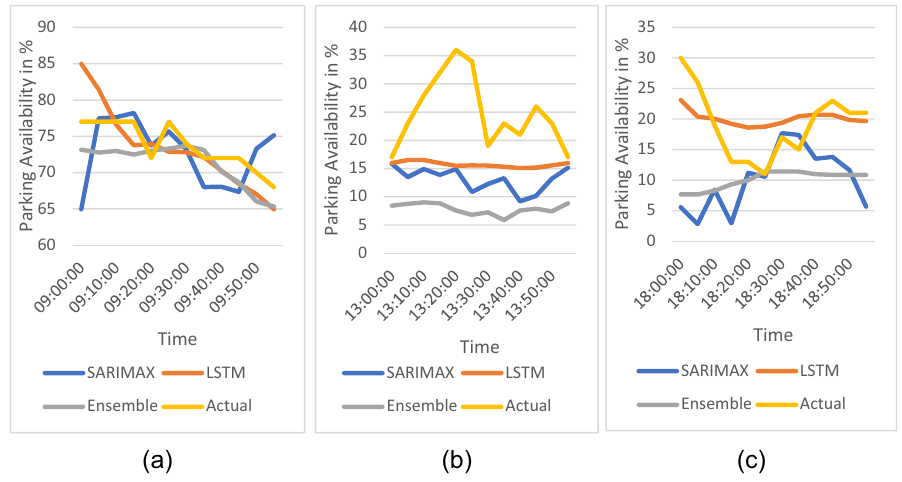
Figure 7: Prediction plot of methods without visitor trend data for weekday. ( a ) Predictions without visitor trend data at 9 AM on a weekday. ( b ) Predictions without visitor trend data at 1 PM on a weekday. ( c ) Predictions without visitor trend data at 6 PM on a weekday.